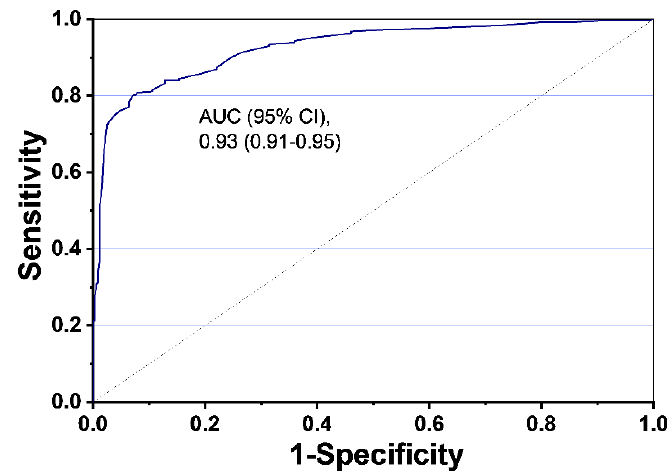
Figure 3. Receiver Operating Characteristic (ROC) curve analysis using the LC index values ( n = 603).